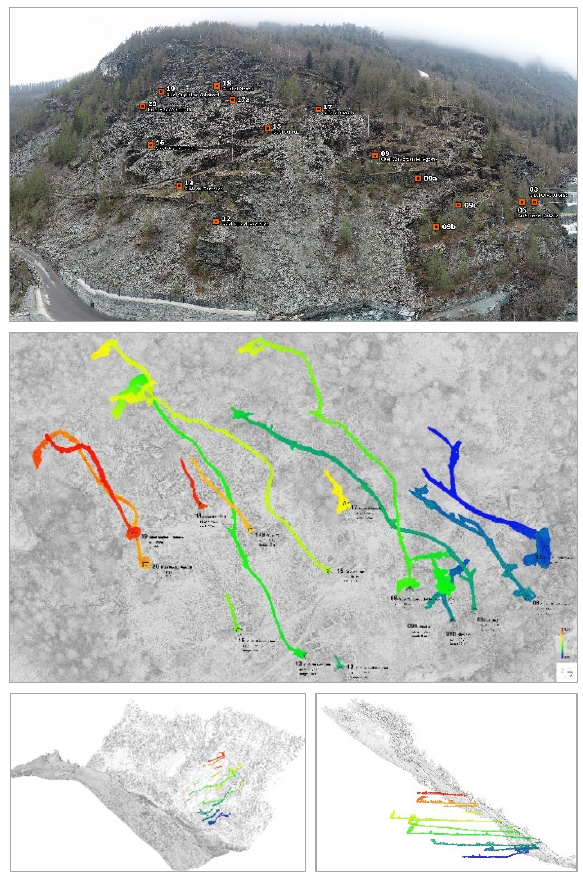
Figure 1. Panoramic view of the slope affected by the tunnel’s entrances (top), and: plan (middle), axonometric (bottom left) and section (bottom right) views of the tunnels.